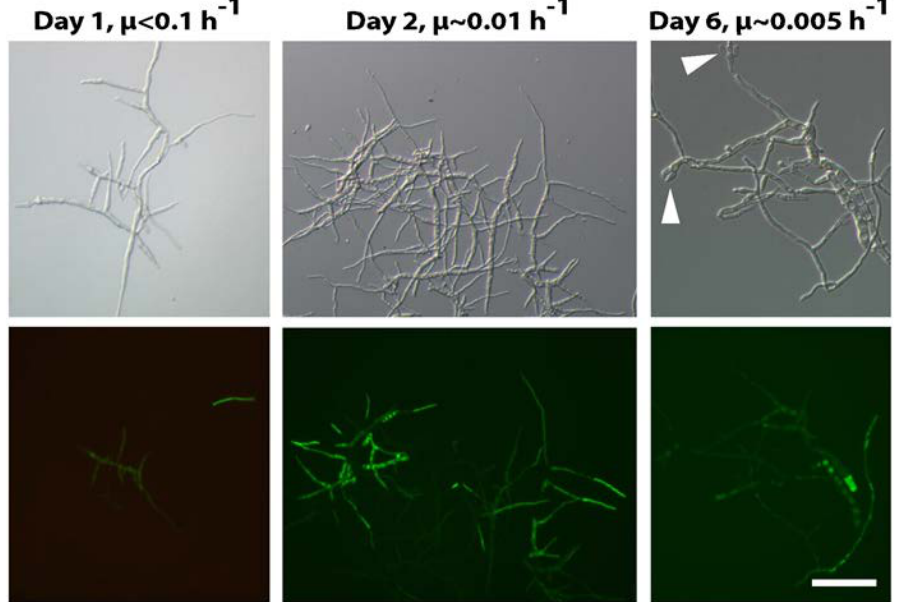
Figure 3. Morphological differentiation of A. niger during substrate-limited growth in retentostat cultures as visualized by DIC (differential interference contrast) microscopy (upper panel) and fluorescence microscopy (bottom panel). Mycelium of an P anafp::eyfp reporter strain after 1 day (µ < 0.1 h − 1 ), 2 days (µ ~ 0.01 h − 1 ), and 6 days (µ ~ 0.005 h − 1 ). Fluorescence represents the activated anafp promoter and is only visible in individual compartments. Note that after day 6, newly formed spores become visible (arrows). Picture is taken from [10], licensed under CC-BY 4.0. µ: growth rate. Bar = 20 µm.